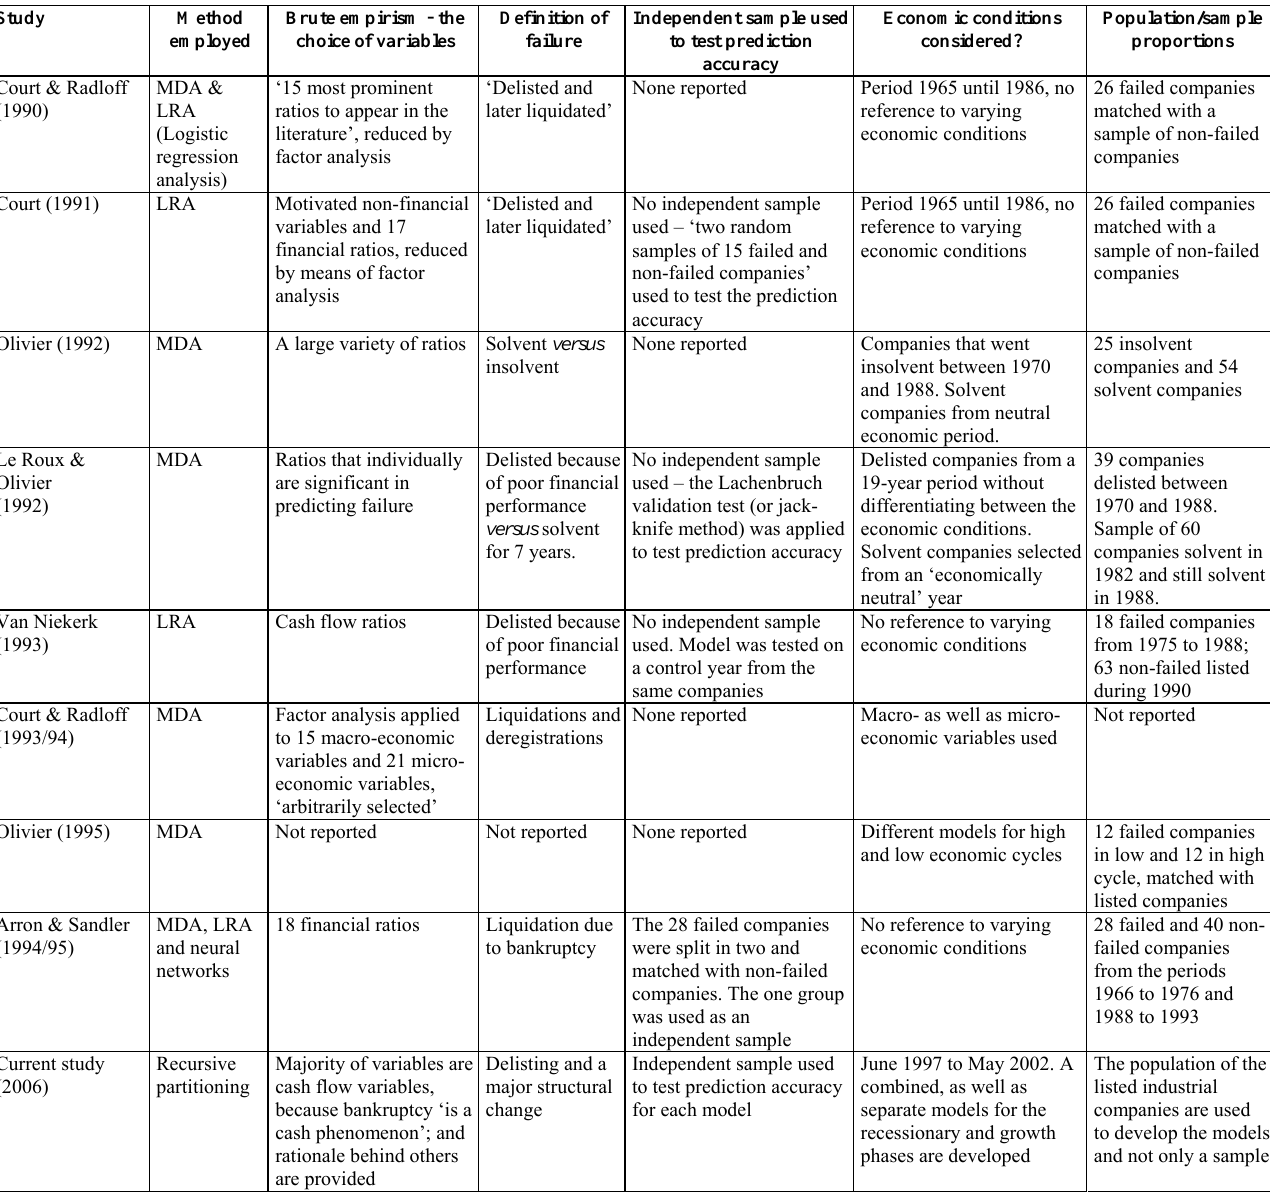
Table 2: Comparison of methodologies of South African studies